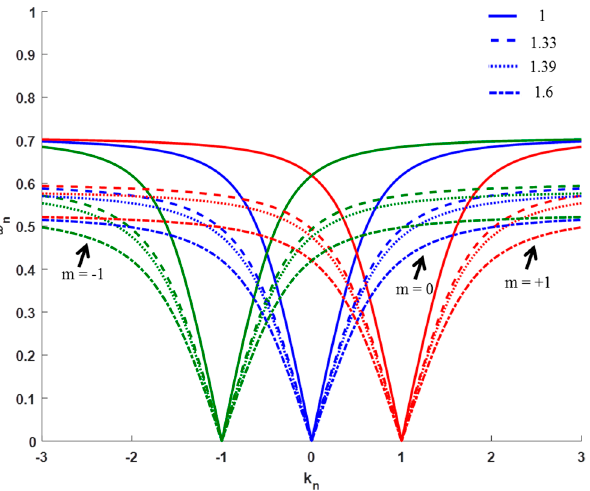
Figure 1. Dispersion relation for ESPM in the grating coupling geometry at different diffraction or- ders and analyte